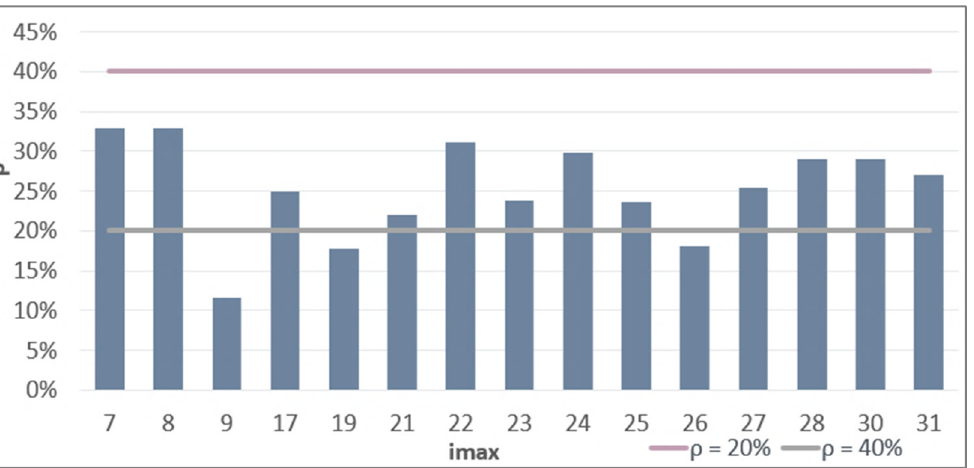
Figure 5. L171: Occupancy percentage in the vehicle at the stops where Maximum Occupancy was observed.